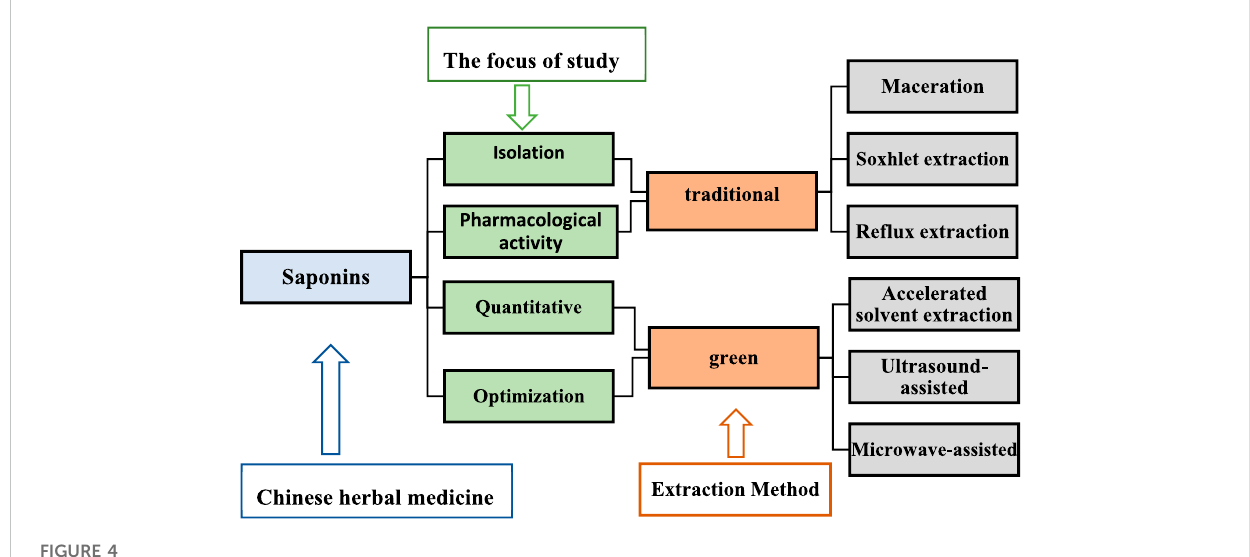
FIGURE 4 The extraction methods of Chinese materia medica